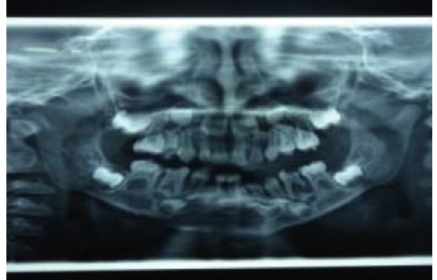
Figure 2: Preoperative